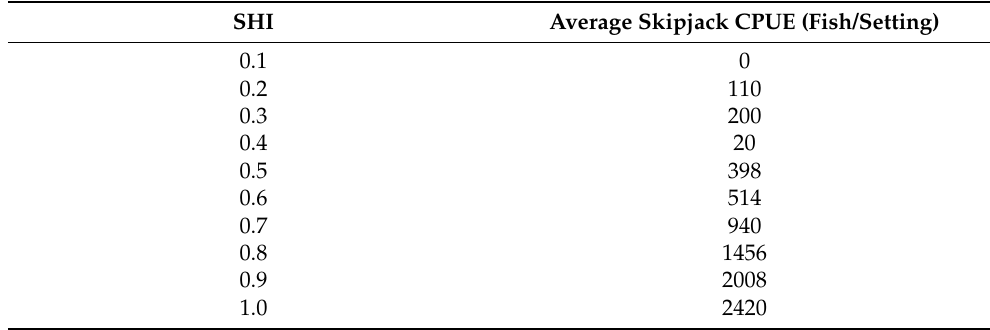
Table 3. Average skipjack CPUE against SHI for validating untrained data of 2017 and 2018. SHI Average Skipjack CPUE